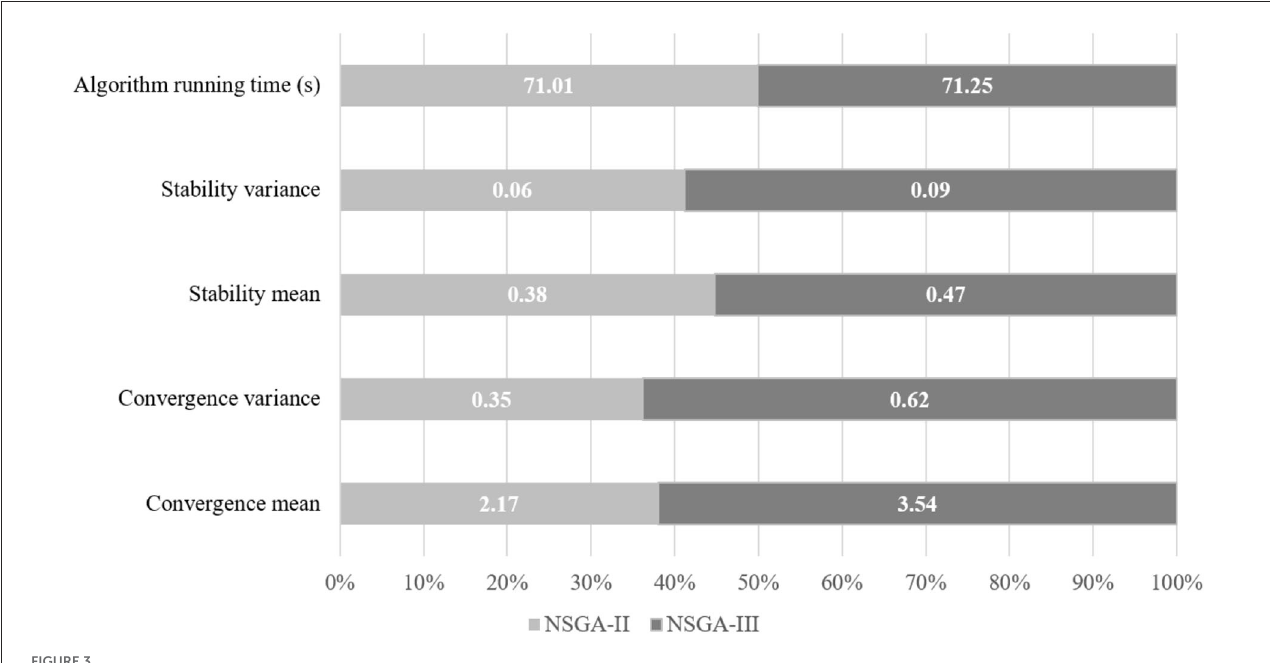
FIGURE3 Performance comparison of NSGA-II and NSGA-III algorithms.